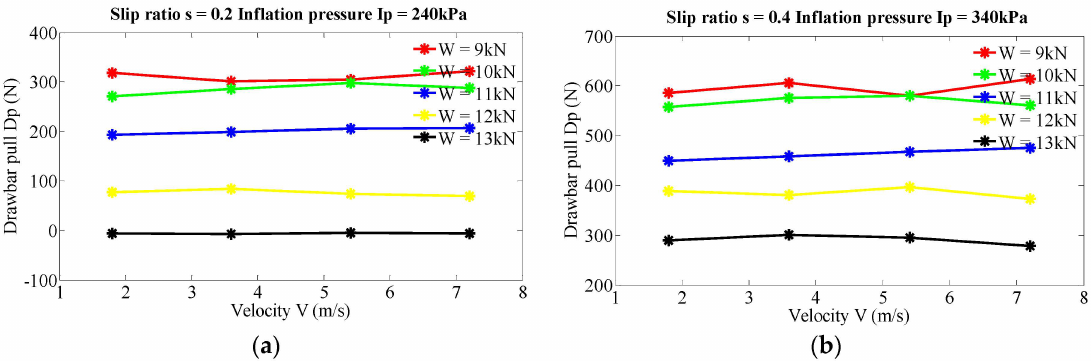
Figure 2. Effect of velocity on drawbar pull at various levels of vertical load, inflation pressure and slip ratio. ( a ) Slip ratio s = 0.2, inflation pressure Ip = 240 kPa; ( b ) Slip ratio s = 0.4, inflation pressure Ip = 340